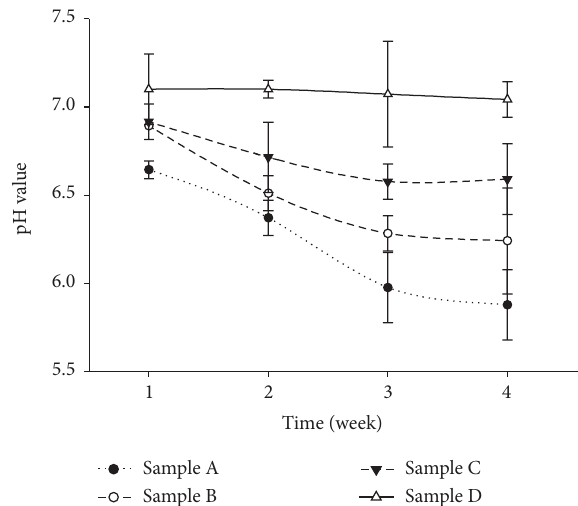
Figure 2: MTT assay was performed to assess the survival and pro- liferation of 3T3 cells when exposed to the testing materials (samples A–D). Significantly cell growth was observed in sample D (silica aerogel to PCL wt/wt ratio 0.5 :1) at day 7 in comparison with other groups ( ∗ 𝑃 < 0.05